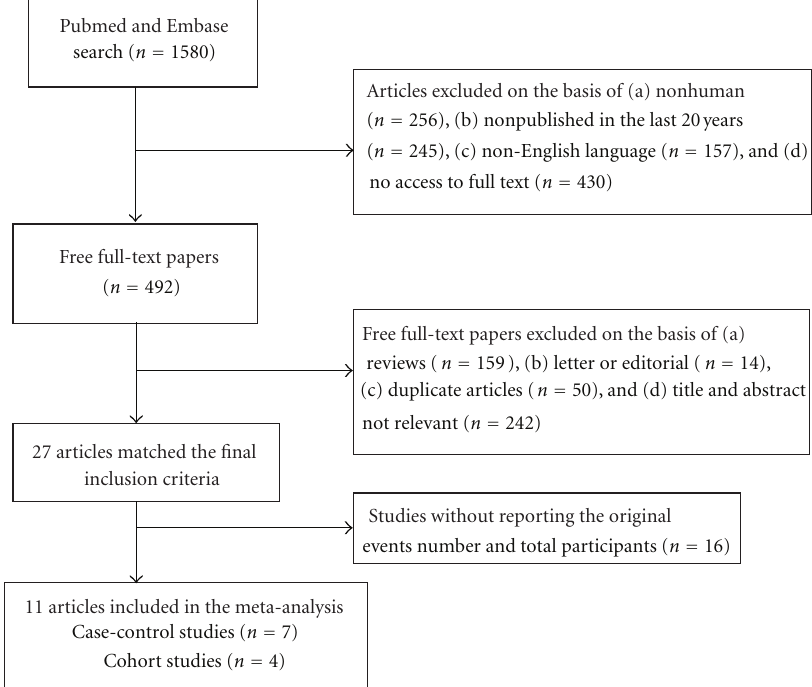
Figure 1: Process of study selection for salt intake and risk of gastric